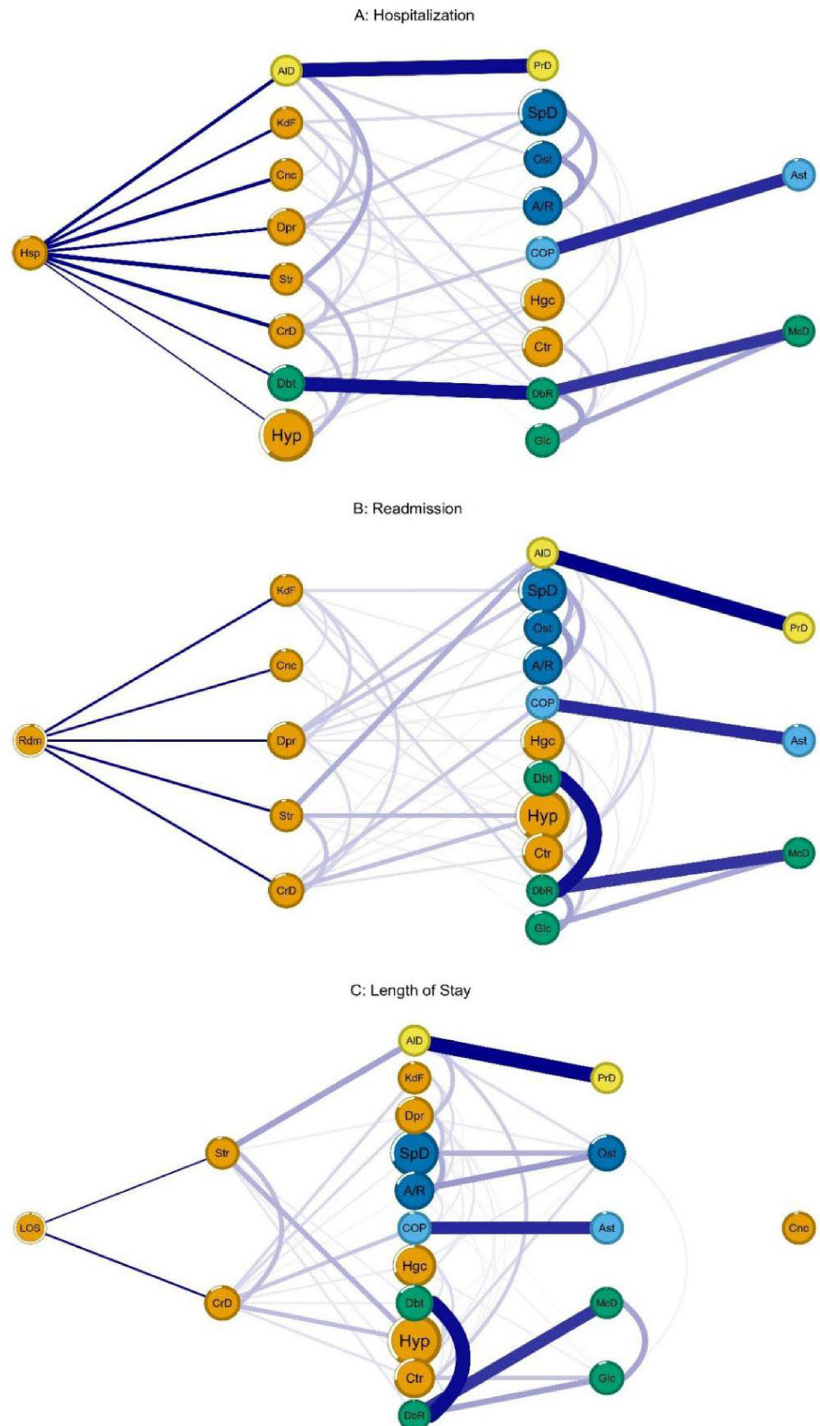
Figure 1. Flow networks of morbidities and hospitalisation variables. The Brazilian Longitudinal Study of Ageing (ELSI-Brazil), 2015—2016. Notes. Disease groups: Cardiometabolic diseases, cancer and others (orange colour): Ctr (Cataract), Hyp (Hypertension), Hgc (High Cholesterol), CrD (Heart Disease), Str (Stroke), Dpr (Depression), Cnc (Cancer), KdF (Kidney Failure), Hsp/Rdm/DoH (hospitalisation/Readmission/ Length of stay); Respiratory diseases (blue colour): Ast (Asthma), COP (Chronic obstructive pulmonary disease); Diabetes and its complications (green colour): Glc (Glaucoma), DbR (Diabetic Retinopathy), McD (Macular Degeneration), Dbt (Diabetes); Neurodegenerative diseases (yellow colour): PrD (Parkinson Disease), AID (Alzheimer Disease); Musculoskeletal disorders (dark blue colour): A/R (Arthritis/Rheumatism), Ost (Osteoporosis), SpD (Spine